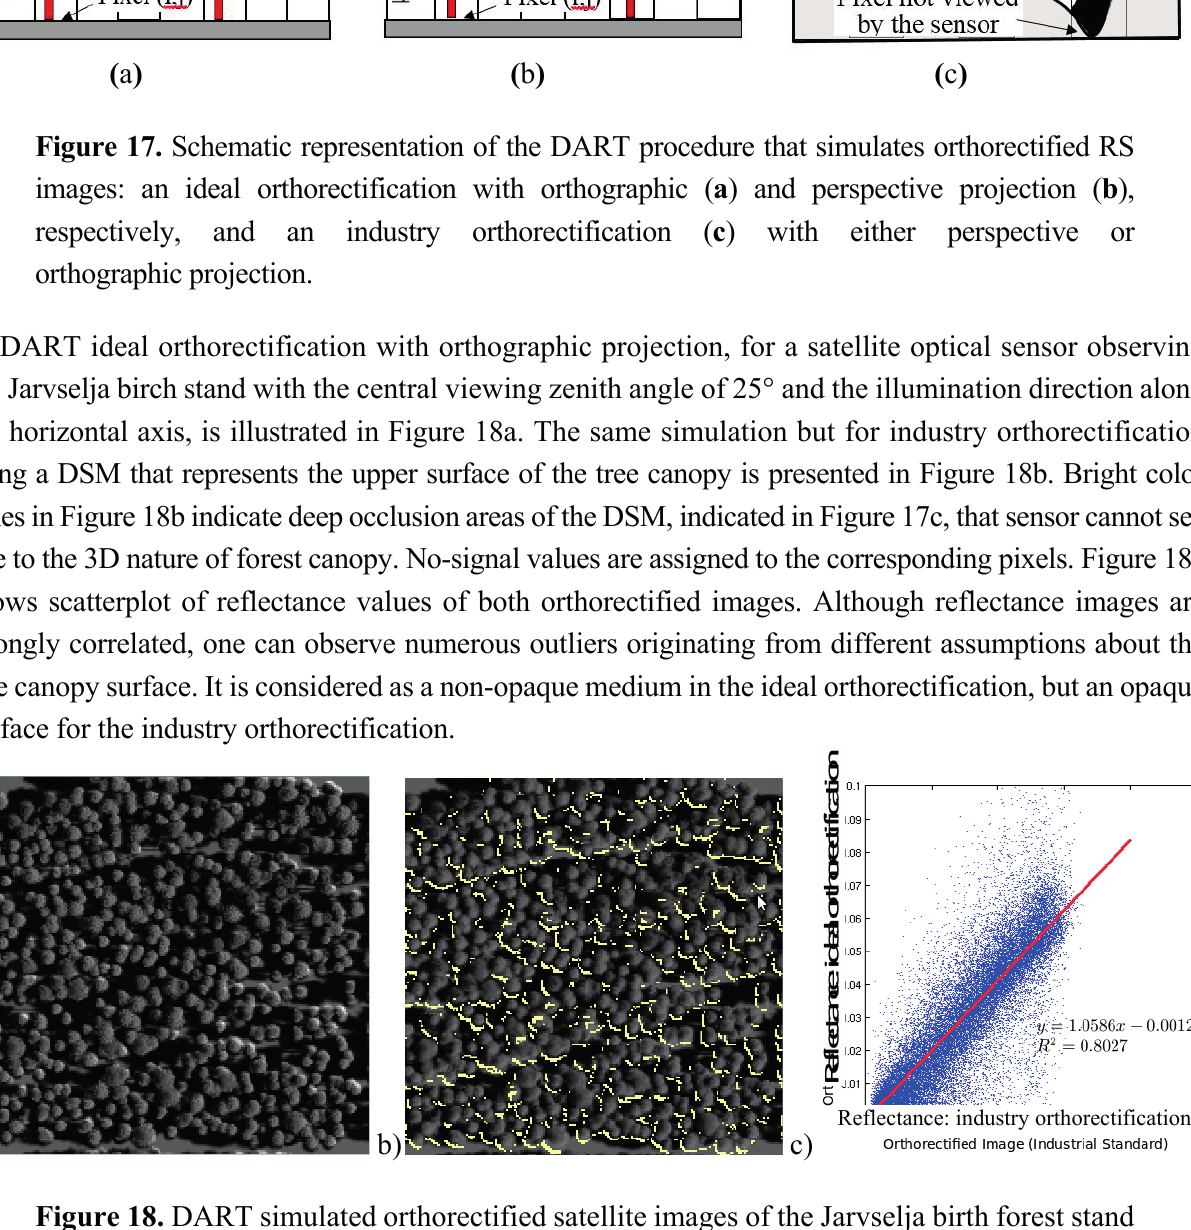
Figure 18. DART simulated orthorectified satellite images of the Jarvselja birth forest stand (Estonia) in summer obtained with ideal ( a ) and industry ( b ) orthorectification (bright tones indicate zones invisible to the sensor, due to the DSM opacity), accompanied by a scatterplot ( c ) displaying linear regression between per-pixel reflectance values of both orthorectified